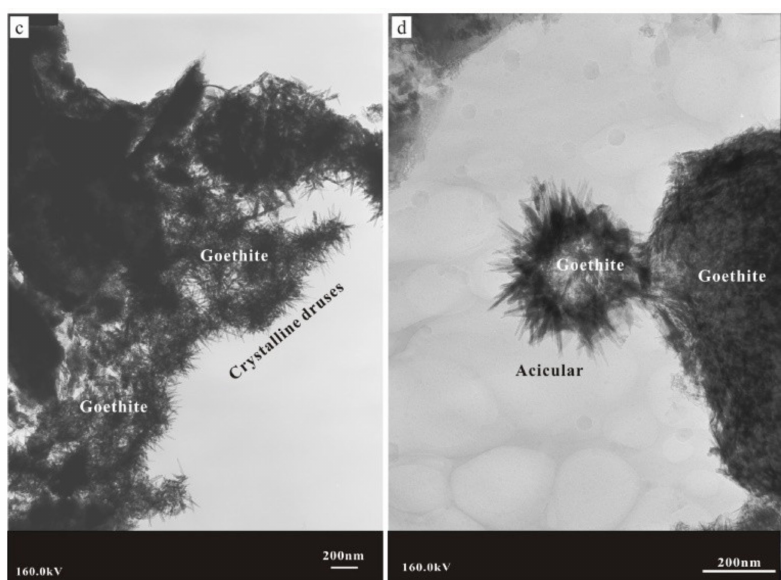
Figure 9. Three-dimensional surface shape of the oxidized Mn–Ag ore from the Sanbao deposit (transmission electron microscopy): ( a ) columnar manganite contains Ag, whereas platy manganite does not contain Ag; ( b ) Ag-rich roman è chite coexisting with goethite; ( c ) the druse of goethite crystals; ( d ) acicular assemblages of goethite